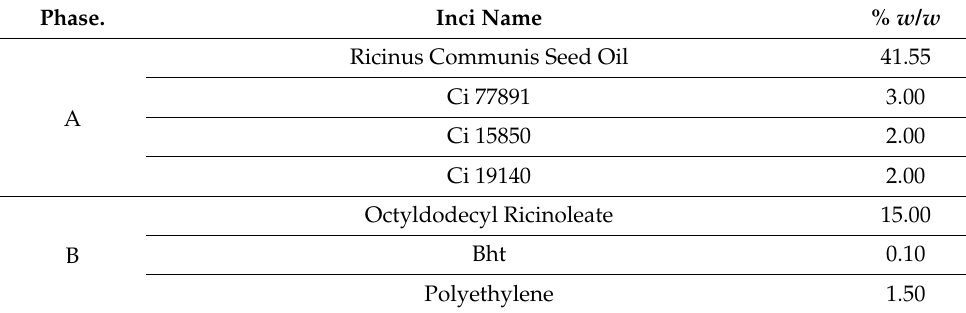
Table 7. Initial lipstick formula (Ref.11/21/1).